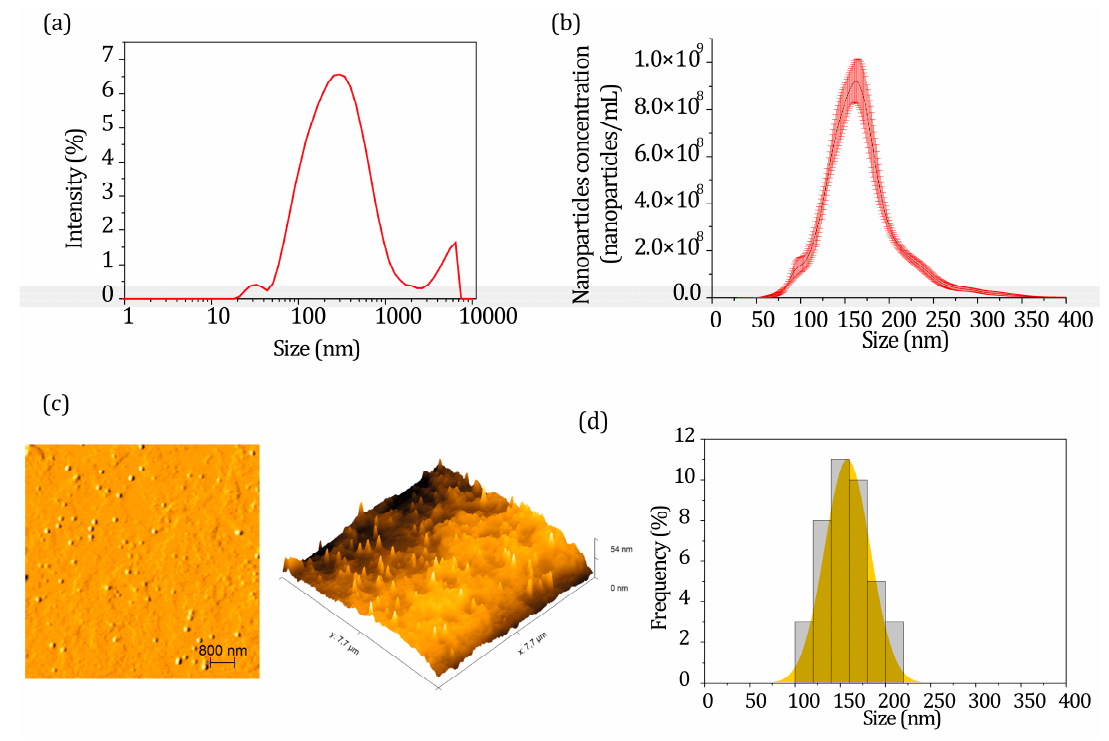
Figure 1. CTS/TPP-EPPR nanoparticle characterization: ( a ) size distribution by DLS (intensity), ( b ) size distribution and nanoparticles concentration by NTA, and ( c ) AFM images (topography image, 3D image, and histogram graphic, from right to left, respectively).